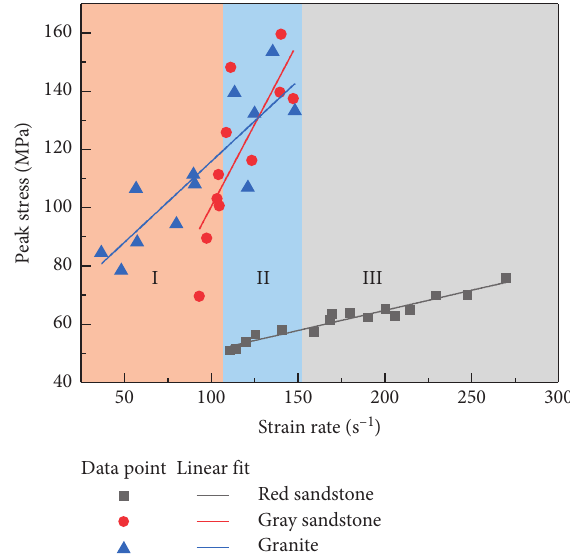
Figure 9: Peak stress-strain rate